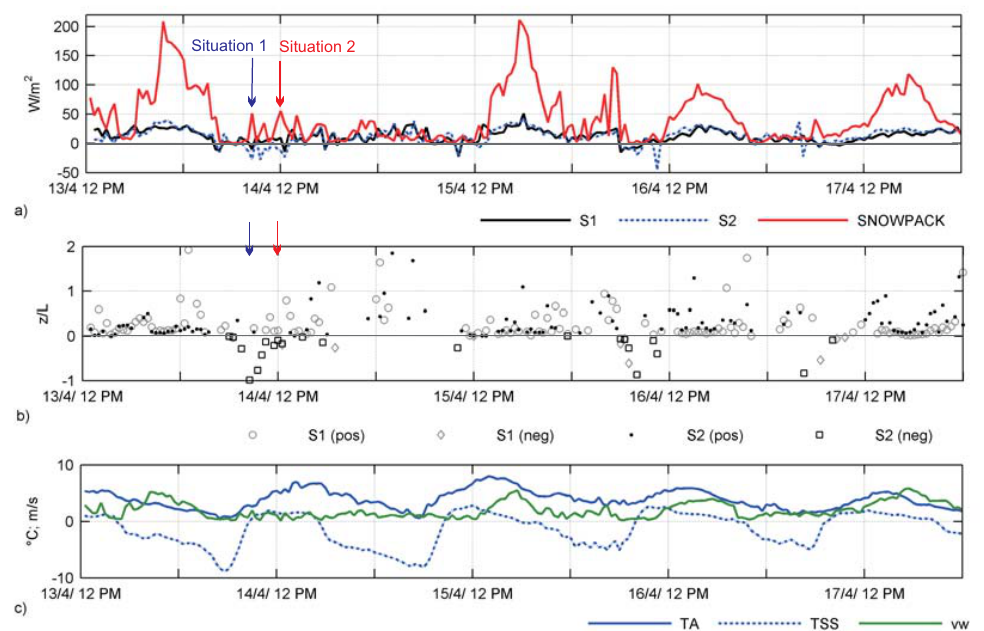
Fig. 9. Time series of measured turbulent heat fluxes ( Q s ) at Sonic 1 (S1) and Sonic 2 (S2), and modeled heat fluxes (SNOWPACK) for time period 13–17 April 2007 (a) . Time series of z/L ( L = Obuhkov length, z = instrument height) at Sonic 1 (S1), located 4m above ground and Sonic 2 (S2), at 2m above (b) . Note that different symbols are used for positive and negative z/L indicating statically stable and statically unstable. Air temperature (TA), snow surface temperature (TSS) and wind velocity (vw) measured at the weather station are also shown (c) for the same time period. Note that atmospheric stability is enabled for SNOWPACK runs. Data marked by situations 1 and 2 are illustrated in Fig.